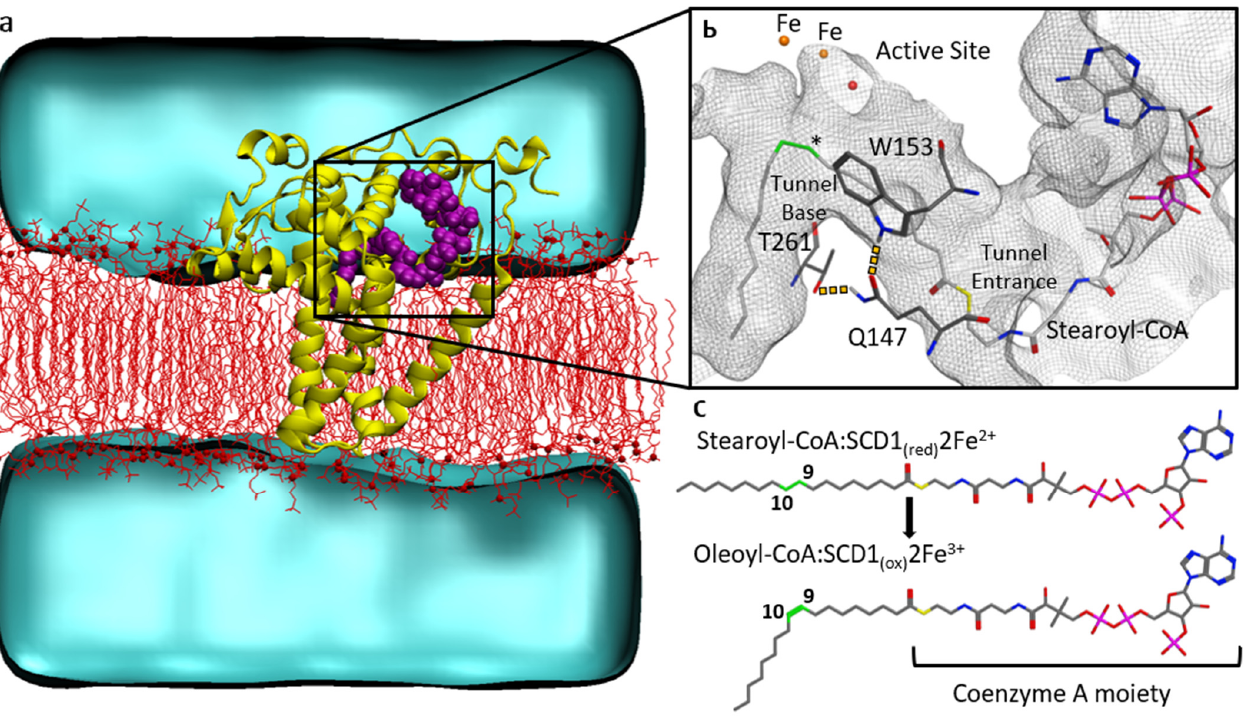
Figure 1. Stearoyl-CoA desaturase 1 ∆ -9 desaturation reaction: ( a ) SCD1 desaturase (yellow) in POPC membrane (lipids as red lines, phosphate groups as red spheres), with stearoyl-CoA substrate (purple), water environment (cyan); ( b ) SCD1 hydrophobic tunnel (gray mesh) with stearoyl-CoA (colored by atom type). Substrate 9th and 10th carbons (green) positioned proximal to the active site’s diiron center (orange), and the oxygen atom of crystallographically determined water (red). Hydrogen bonding between residues in yellow dashes. ( c ) The SCD1 desaturation reaction, resulting in a double bond at the ∆ -9 position (indicated with asterisk), converting stearoyl-CoA (substrate) to oleoyl-CoA